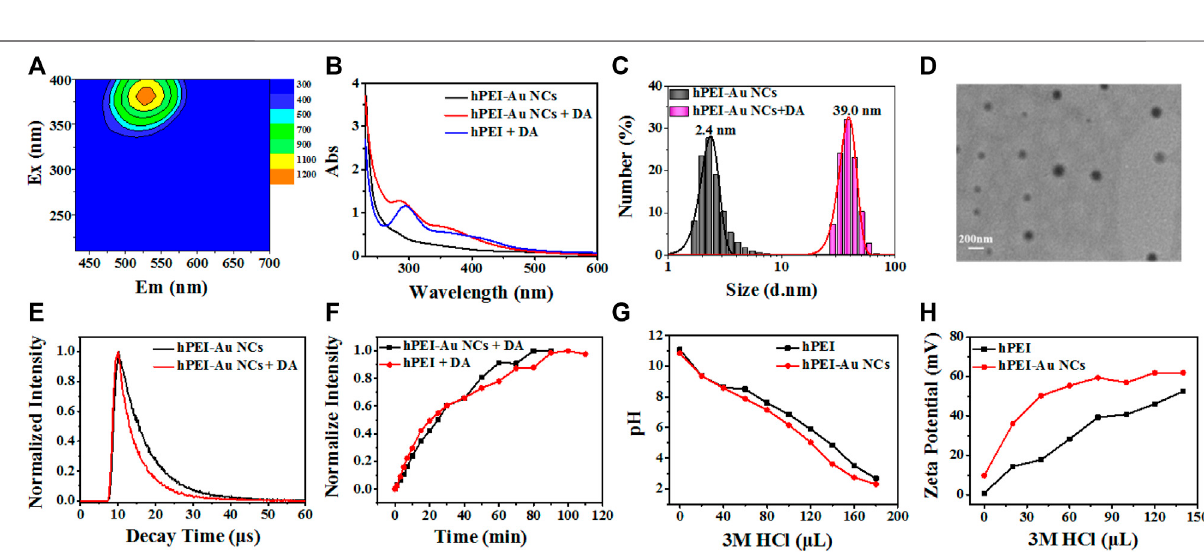
Frontiers in Chemistry |